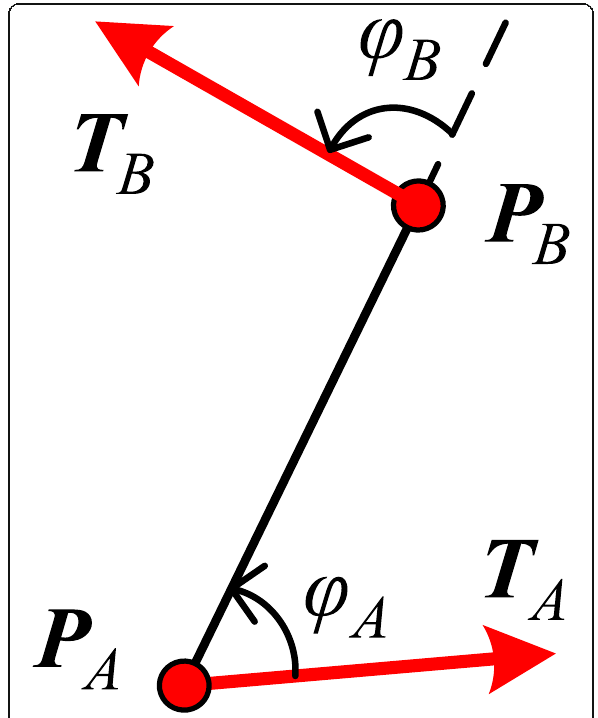
Fig. 4 Angle from vector T A to vector P A P B , and from P A P B to T B